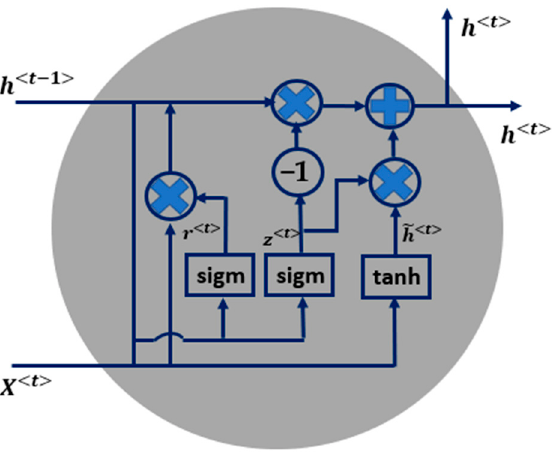
Figure 3. Illustration of long short-term memory (LSTM) unit, having three gates and a memory cell state.